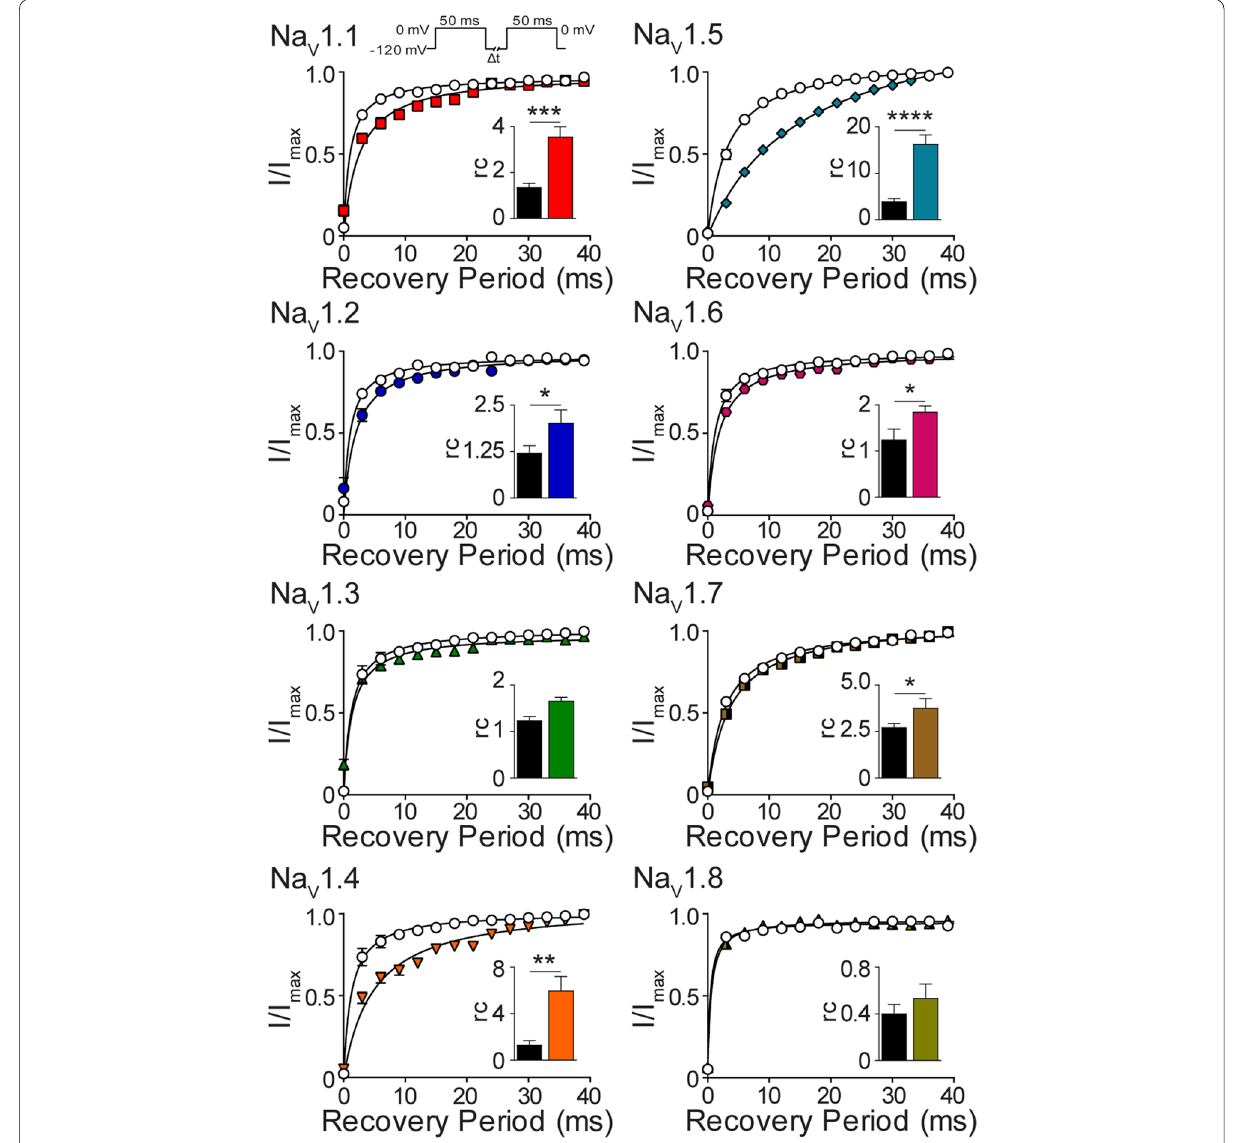
Fig. 3 The effect of NP on sodium channel recovery from fast inactivation. Recovery of channel availability from fast inactivation as a function of time, evoked by the indicated voltage protocol (inset), in the presence of DMSO vehicle ( ) or NP (3 μg NP/mL) for Na V 1.1 ( ; n 10), Na V 1.2 ( = ; n 8), Na V 1.3 ( ; n 10), Na V 1.4 ( ; n 6), Na V 1.5 ( ; n 10), Na V 1.6 ( ; n 11), Na V 1.7 ( ; n 7) and Na V 1.8 ( ; n 7). A hyperbola was fitted to = = = = = = = pooled averages. Insets show the mean rc values in the presence of DMSO vehicle (black bars) or NP (coloured bars as described above). Data points are mean SEM. Statistical significance is marked as * p <0.05, ** p <0.01, *** p <0.001, **** p ±